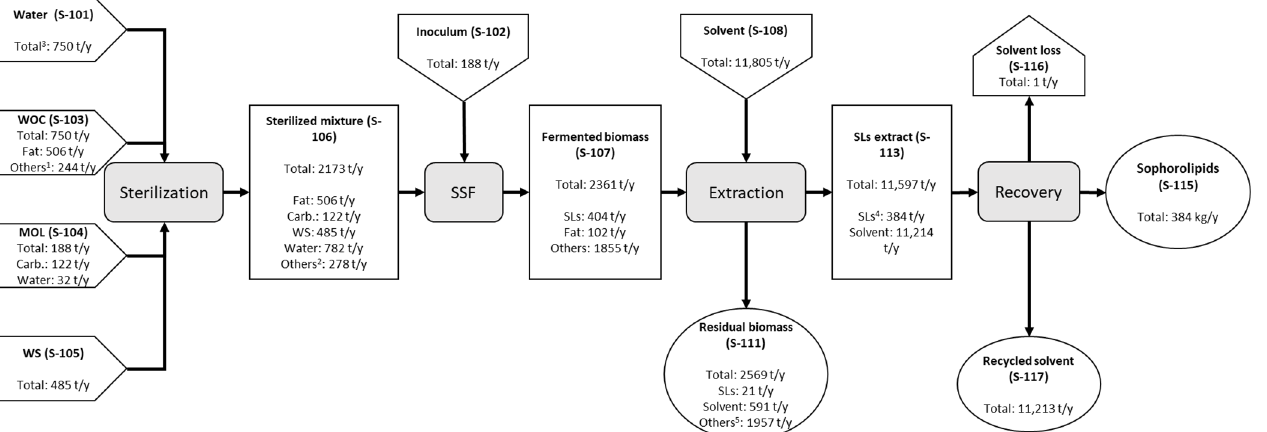
Figure 2. Major flows of the mass balance for the production of sophorolipids through Solid-State Fermentation. 1 Inert materials, not used in the bioconversion; 2 Material not considered as soluble carbohydrates and fats from MOL or WOC (proteins, fiber, and ash). 3 Water added to the solid mixture to reach water content suitable for yeast growth; 4 SL includes sophorolipids and impurities; 5 Includes reactive and non-reactive materials apart from fats entering the fermentation stage and cell proliferation during fermentation.